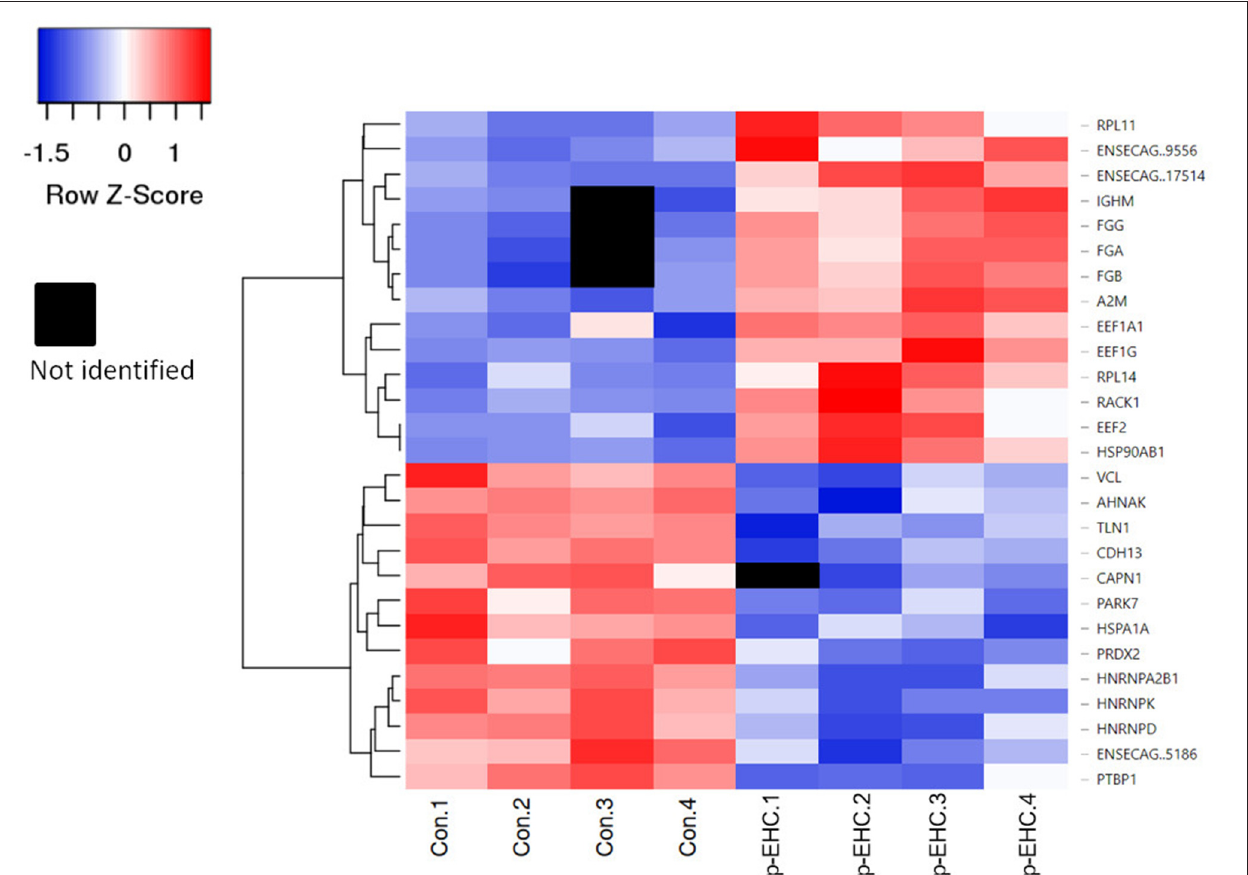
Frontiers in Veterinary Science |